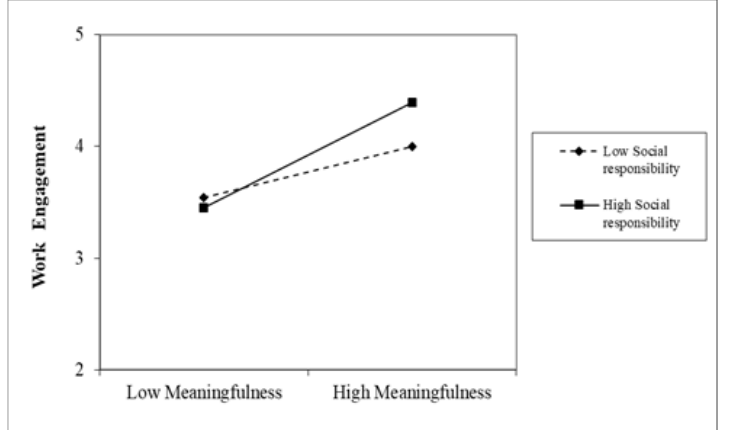
Figure 2. Simple slopes for the interaction between work meaningfulness and social responsibility climate on work engagement.